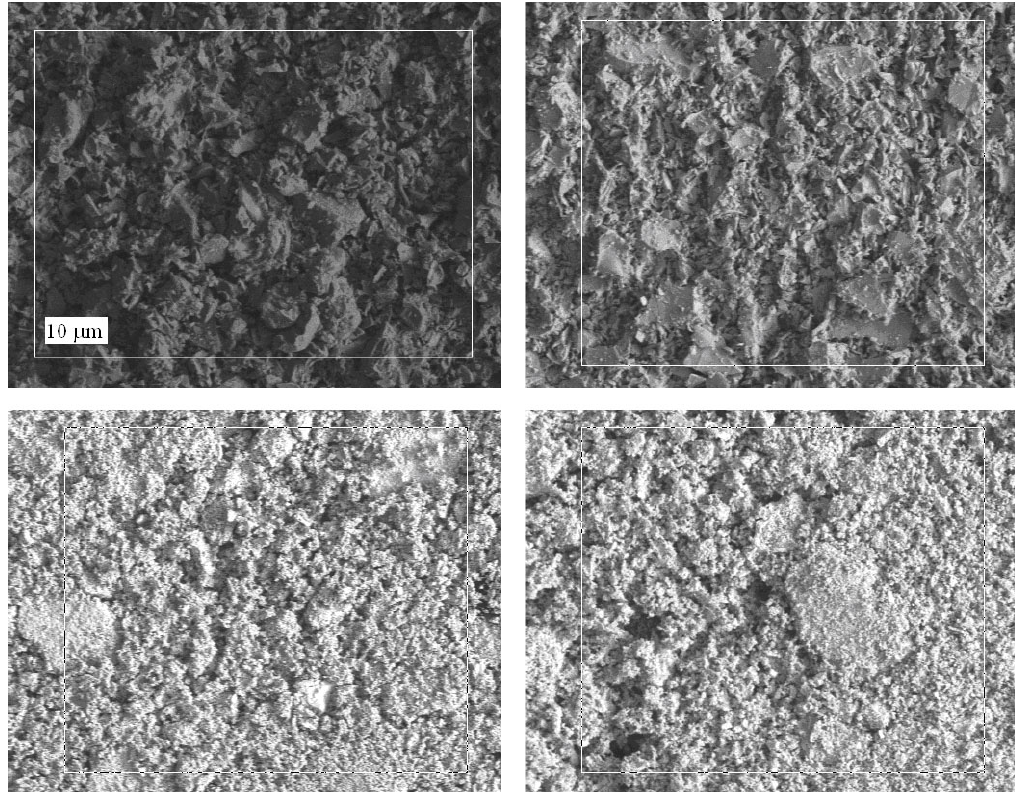
Figure 8. Scanning electron micrographs of sol-gel-derived CoAl